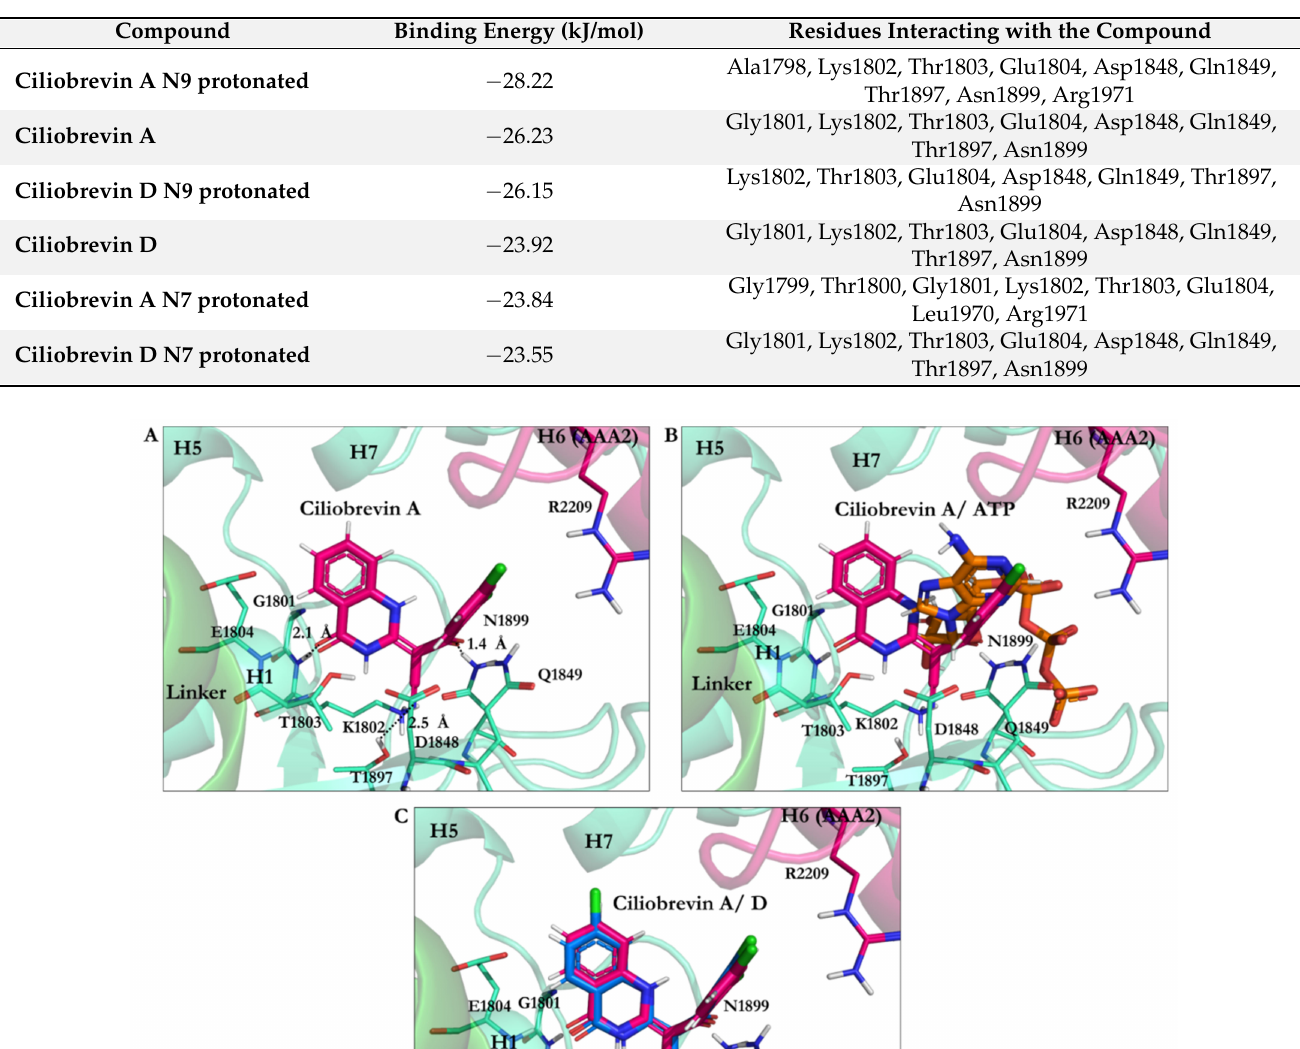
Table 6. Amino acids affected by ciliobrevin A and D in their protonated and deprotonated states.